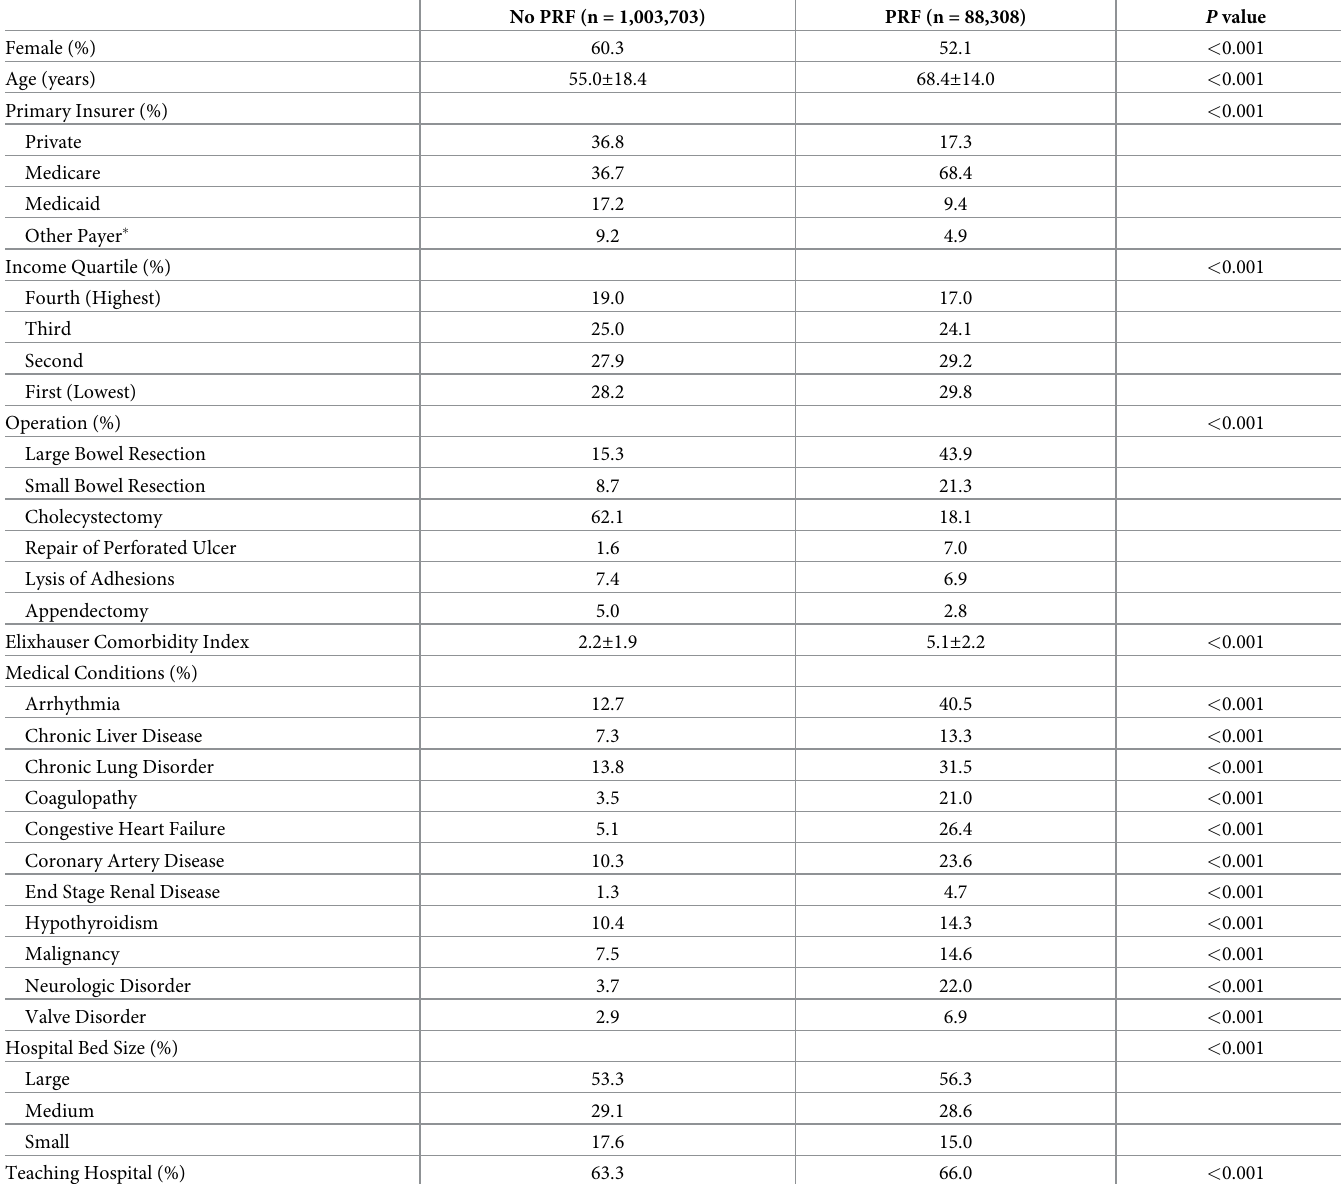
Table 1. Comparison of patient and hospital characteristics stratified by the development of postoperative respiratory failure